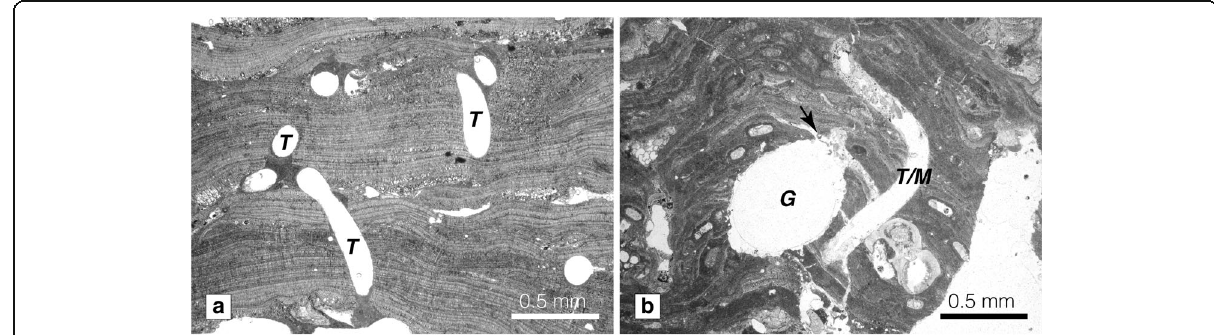
Fig. 10 Thin section photomicrographs showing Gastrochaenolites ( G ), Trypanites ( T ), and Trypanites / Maeandropolydora ( T / M ) in rhodoliths off Fraser Island. a Cylindrical tubes of Trypanites bore successive coralline thallial growth increments. b Encrusting coralline thallus (arrow) overlying